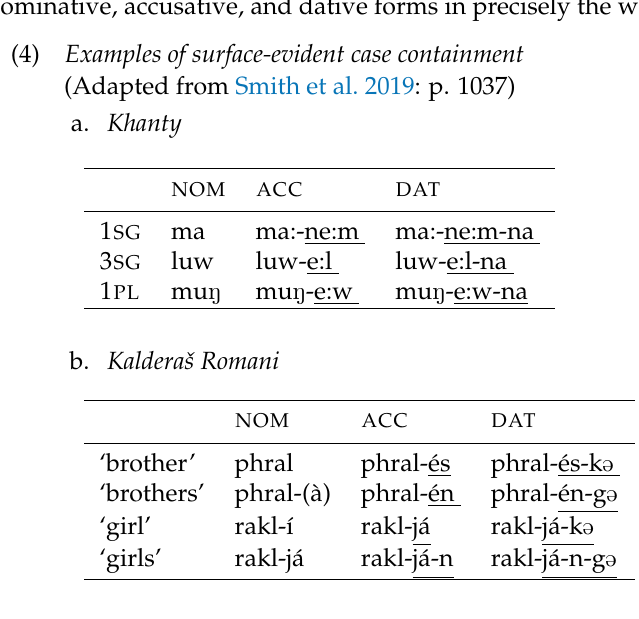
küsün turad 1 vase